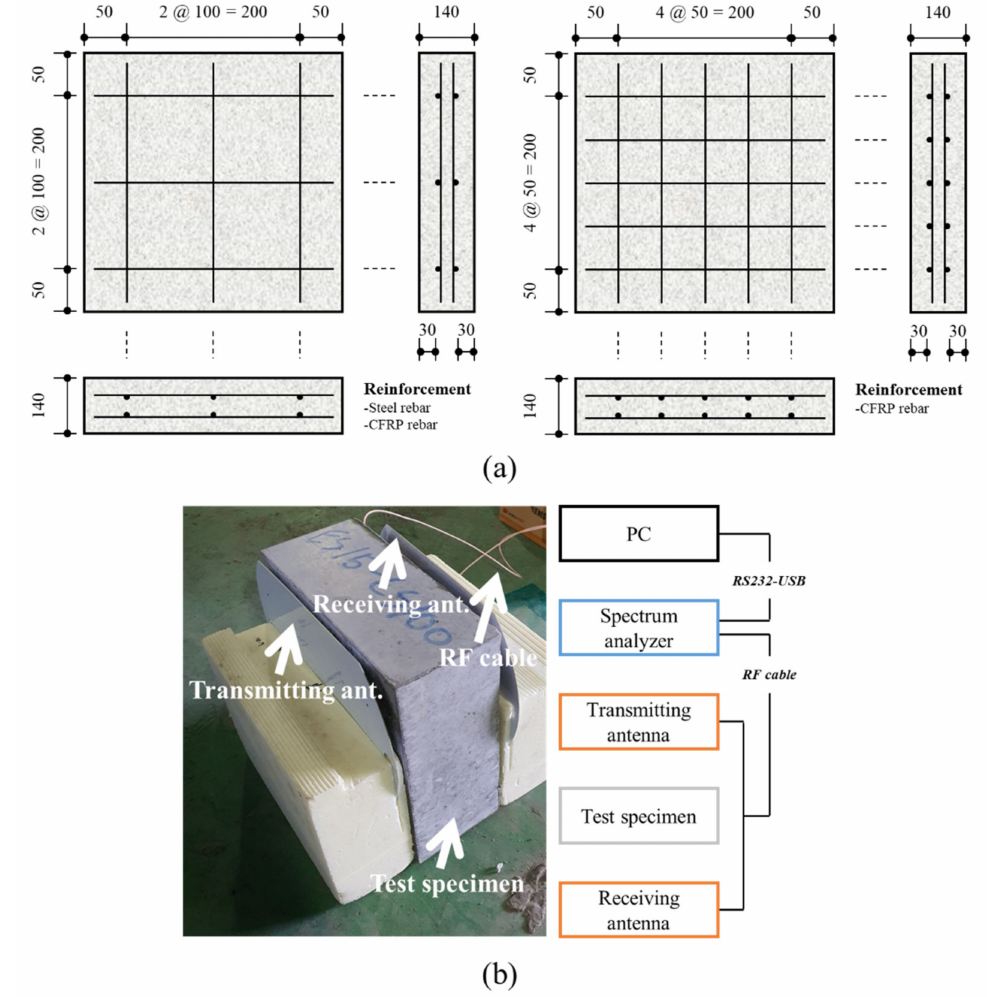
Figure 4. Details for measuring shielding effectiveness of concrete: ( a ) specimen details; ( b ) test